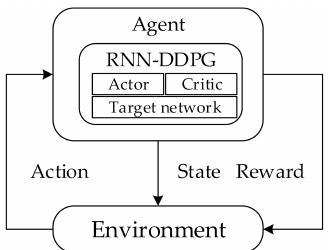
Figure 2. The traffic flow prediction strategy based on RNN combined with the DDPG